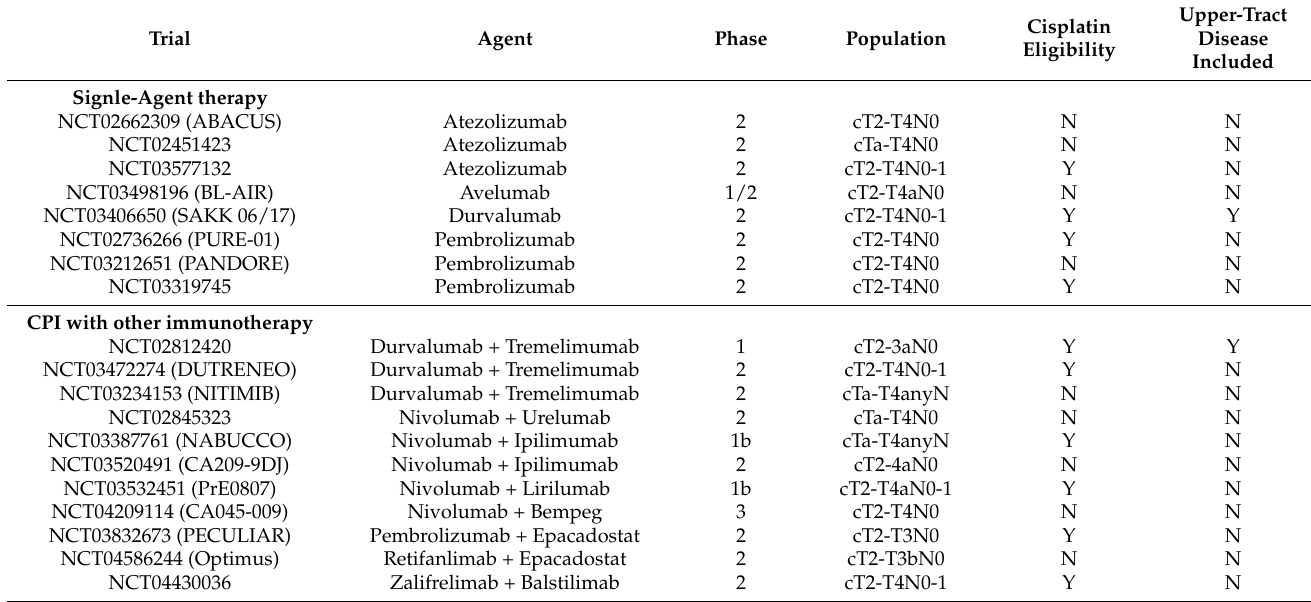
Table 4. Summary of current neoadjuvant trials for immunotherapy with or without other agents in MIBC.